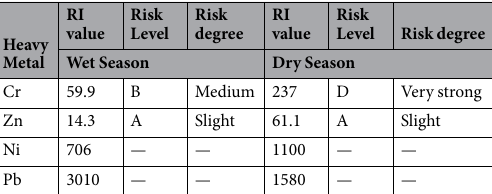
Table 5. Comprehensive Potential Ecological Risk Levels for the Heavy